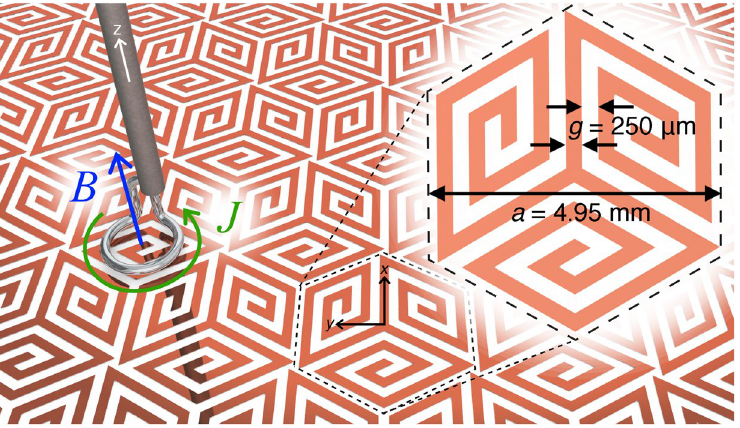
Figure 1. The spiral metasurface with unit cell geometry shown inset. The surface mode is coupled to the mode of a coaxial cable via a loop antenna positioned above the centre of a spiral arm. A second identical antenna scans the surface from the opposite